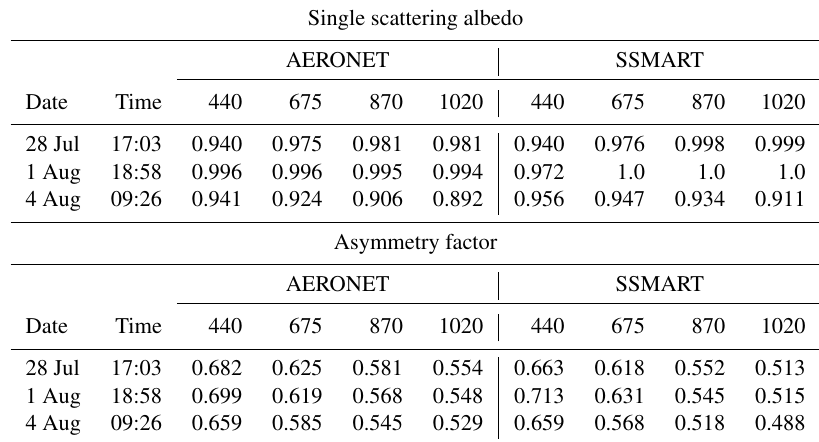
Table 4. Single scattering albedo and asymmetry factor, retrieved using the AERONET algorithm and SSMART software package. Single scattering albedo AERONET